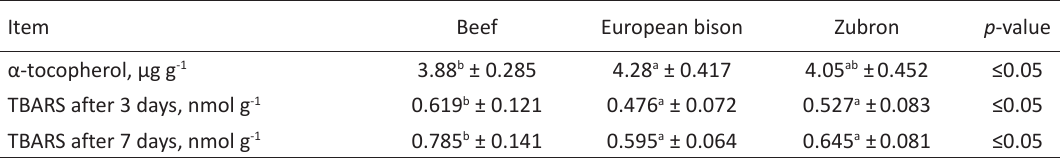
Table 5. Content of α-tocopherol and TBARS value after cold storage of the meat Item